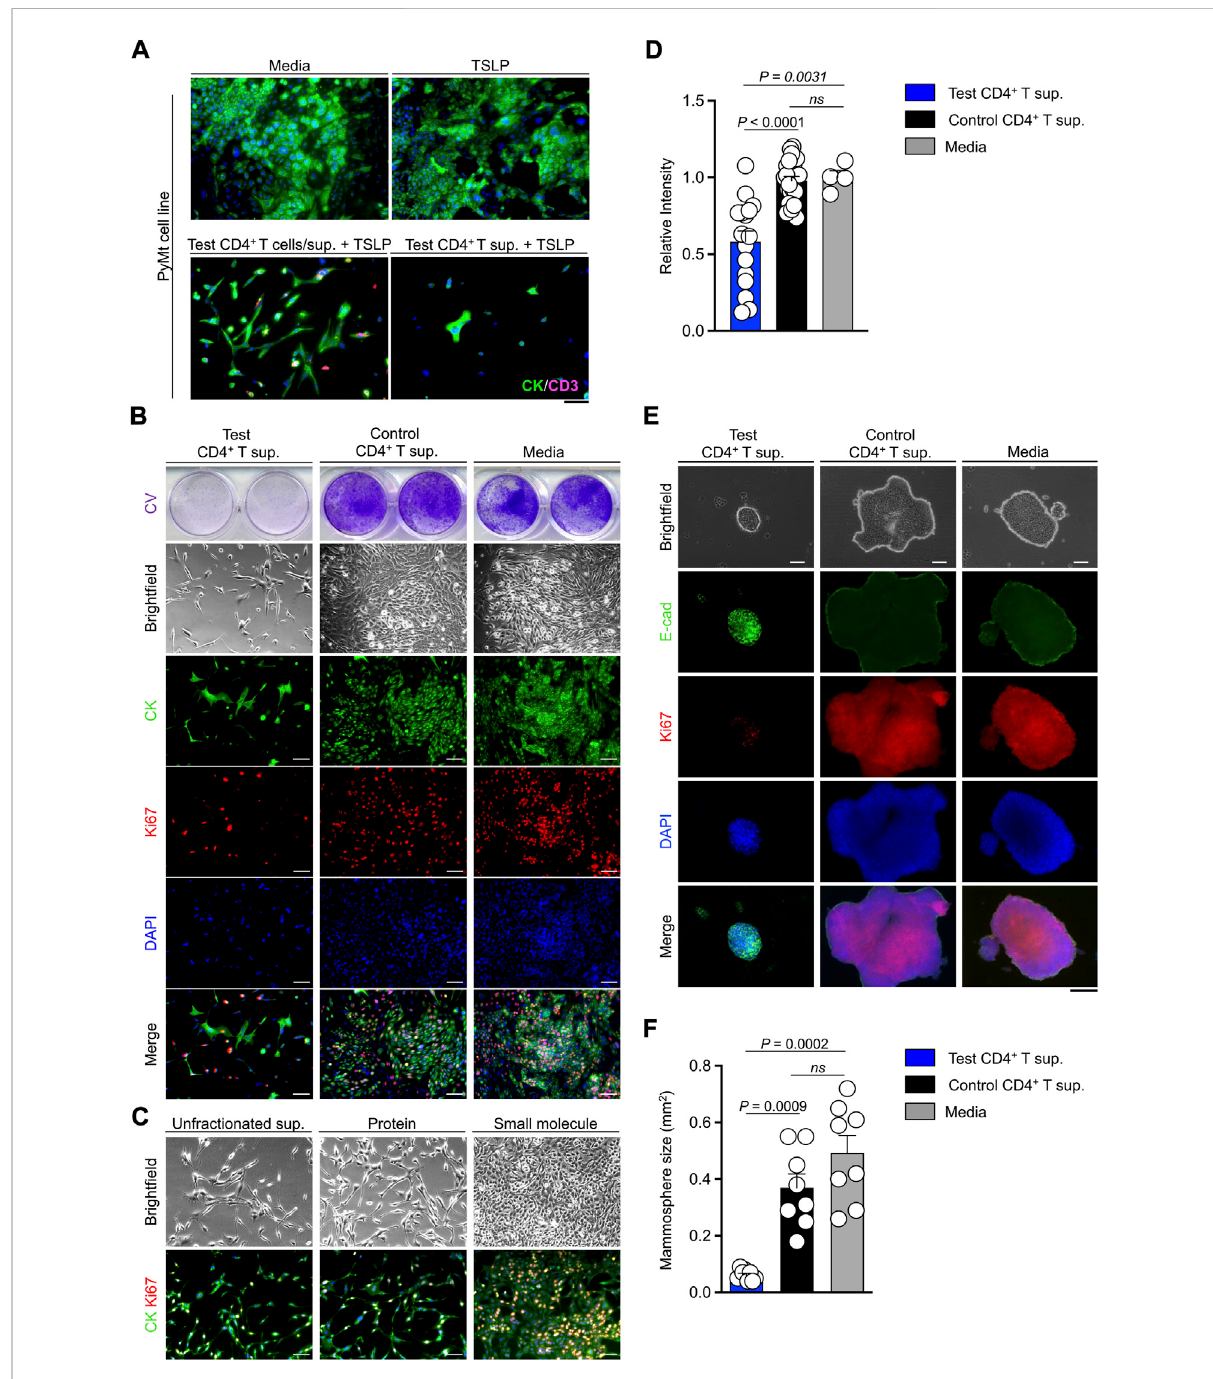
FIGURE 2 TSLP-activated CD4 + T cell supernatant blocks PyMt cell proliferation in vitro . (A) Representative images of cytokeratin (CK) and CD3 + T cells (CD3) immuno fl uorescence staining on 2D PyMt culture treated with media alone (top left), media plus TSLP (top right), TSLP-activated WT CD4 + T cells (test CD4 + T cells), their supernatant (sup.) and TSLP (bottom left), or CD4 + T cell supernatant and TSLP (bottom right). (B) Representative imagesof2Dproliferation assaywithcrystalvioletstaining(upperpanels),bright fi eld(middlepanels),andimmuno fl uorescencestainingforCK/ Ki67/DAPI (lower panels) on PyMt cell line treated with test CD4 + T supernatant, control Tslpr KO CD4 + T supernatant, or media alone. Supernatants were from the second and third rounds of CD4 + T cell stimulation ex vivo . (C) Representative images of 2D proliferation assay with bright fi eld (top panels) and immuno fl uorescence staining for CK/Ki67 (lower panels) on PyMt cell line treated with unfractionated test CD4 + T supernatant, protein fractionfromtestCD4 + Tsupernatant,orsmallmoleculefractionfromtestCD4 + Tsupernatant. (D) Quanti fi